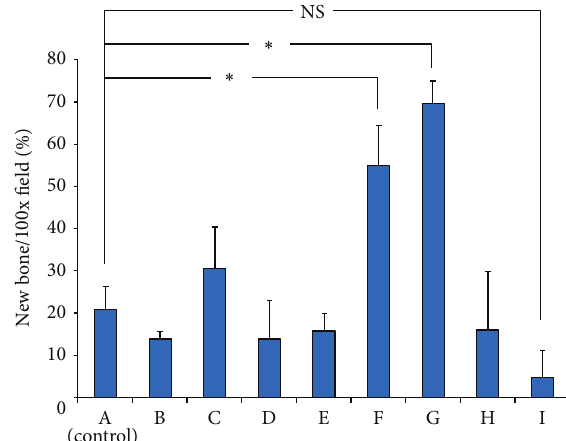
Figure 6: Percentage of newly formed bone in the high magnifi- cation field. Values are shown as mean ± standard deviation (SD, ∗ 𝑃 < 0.01 ). The values are significantly higher in groups F and G (1 and 5 𝜇 g G-CSF with gelatin hydrogel, resp.) compared to group A ( 𝛽 -TCP alone).